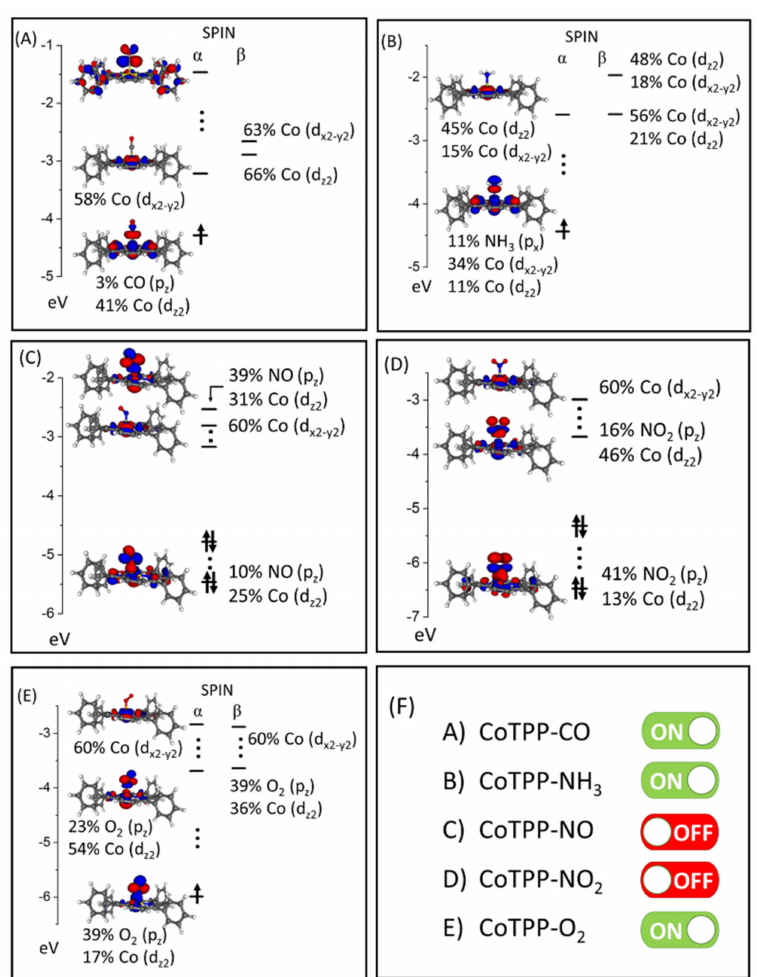
Figure 2. Energy level diagrams of selected frontier MOs of ( A ) CoTPP–CO, ( B ) CoTPP– NH 3 , ( C ) CoTPP–NO, ( D ) CoTPP–NO 2 , and ( E ) CoTPP–O 2 (displayed isosurfaces correspond to ± 0.03 e 1/2 × A − 3/2 ). ( F ) Scheme of the “switch on”/“switch off” behaviour upon coordination of L to CoTPP. Vertical dots indicate that some levels, mainly localized on the TPP fragment, are omitted. Colour codes are the same adopted in Scheme